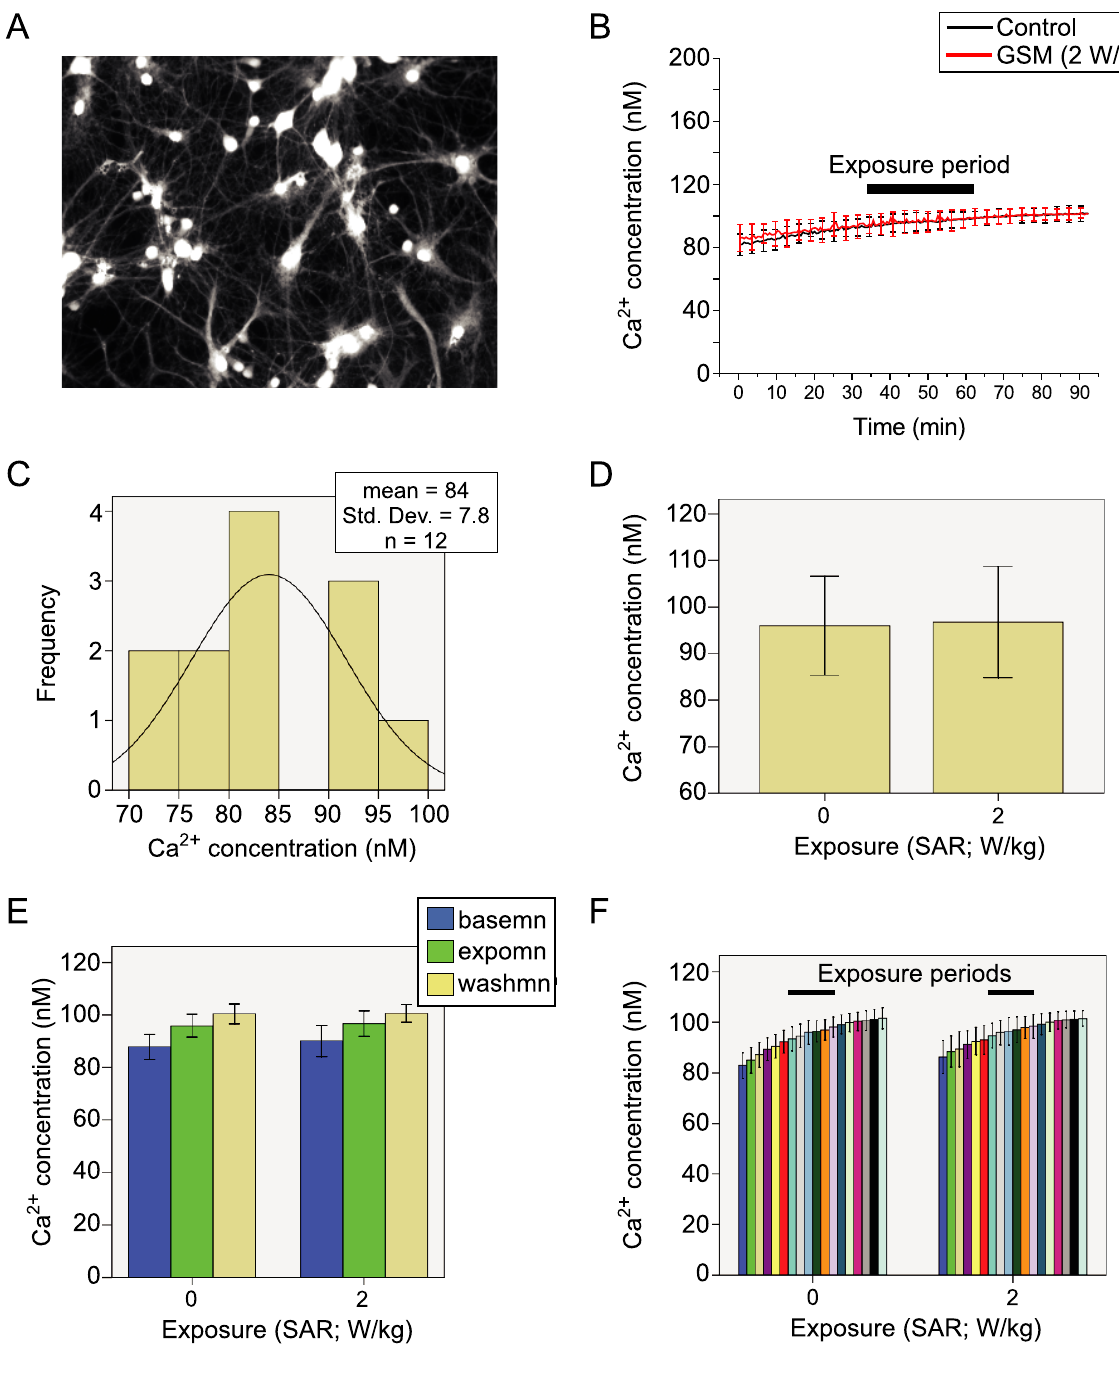
Figure 8. RF Exposure has no influence on Ca 2 + in Hippocampal neurons. A ; image of cultured hippocampal neurons loaded with the Ca 2 + indicator Fura2-PE3. B ; Sample trace showing the experimental protocol. The recordings from the hippocampal neurons over the experimental time course comprised baseline, exposure and washout periods, each lasting 30 minutes. Neurons were imaged while placed in one of two TEM cells, receiving either a 900 MHz GSM field at an SAR of 2 W/kg or a sham exposure by being in the un-energized TEM cell. C ; the baseline Ca 2 + concentration of hippocampal neurons was normally distributed around a mean of 84 nM with a SD of 7.8. D ; the mean Ca 2 + concentration of hippocampal neurons for the RF exposure period. No significant difference was observed (F(1,11)=0.06, p=0.81) between the GSM 2 W/kg exposed and control samples. E ; a mixed model repeated measures analysis of variance was performed comparing the baseline, exposure and washout periods between the GSM-exposed and control samples A significant increase in Ca 2 + concentration was observed across the three time periods (F(1.27,12.68)=74.93, p , 0.01), however, there was no significant interaction with the exposure SAR, indicating that the linear increase over time occurred equally in the hippocampal neurons exposed to the GSM and control conditions (F(1.27,12.66)=0.65, p=0.47). F ; no significant transient changes in Ca 2 + concentration were observed when the GSM and control conditions were compared with a repeated measures model with 5-minute temporal bins (F(2.11, 21.14)=0.87, p=0.44). Greenhouse-Geiser corrected statistics were used.